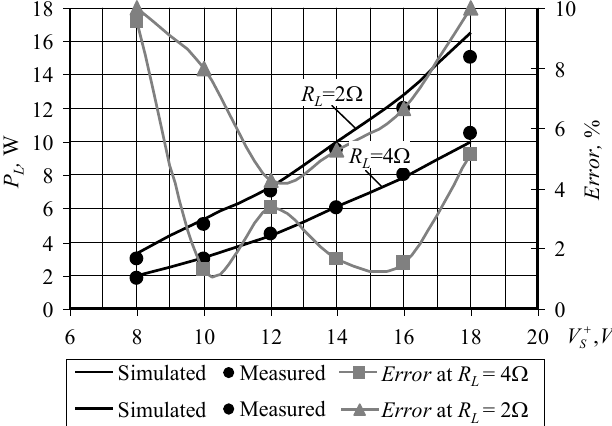
Figure 9. Output power P L versus power supply voltage + V S .